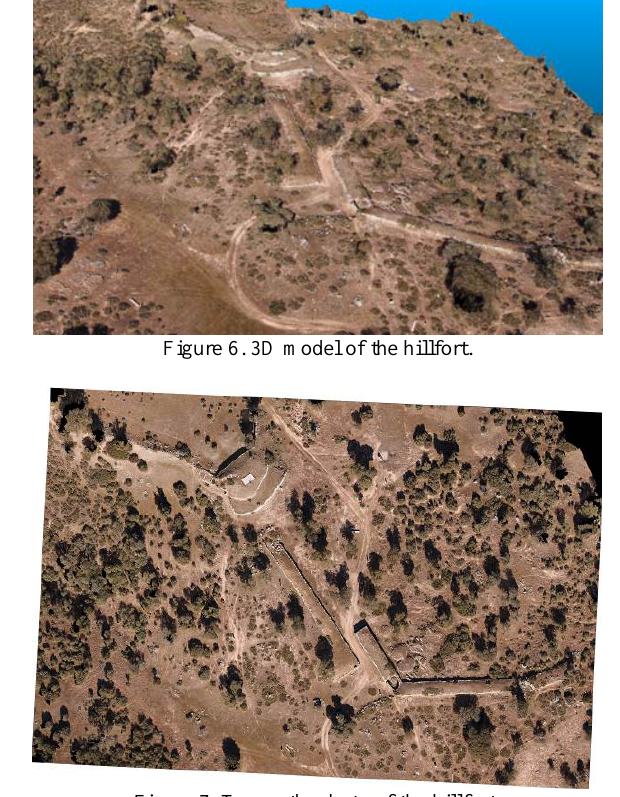
Table 3. Self-calibration parameters of Fraser model. After the non-linear computation of the self-calibration, in the 29th iteration, the residual of the adjustment reached 0.68 pixels. Figure 6 shows the final point cloud which includes a total of 15.8 million points, which means, for the scenario area, an equivalent point density of 229 points/m 2 . The whole